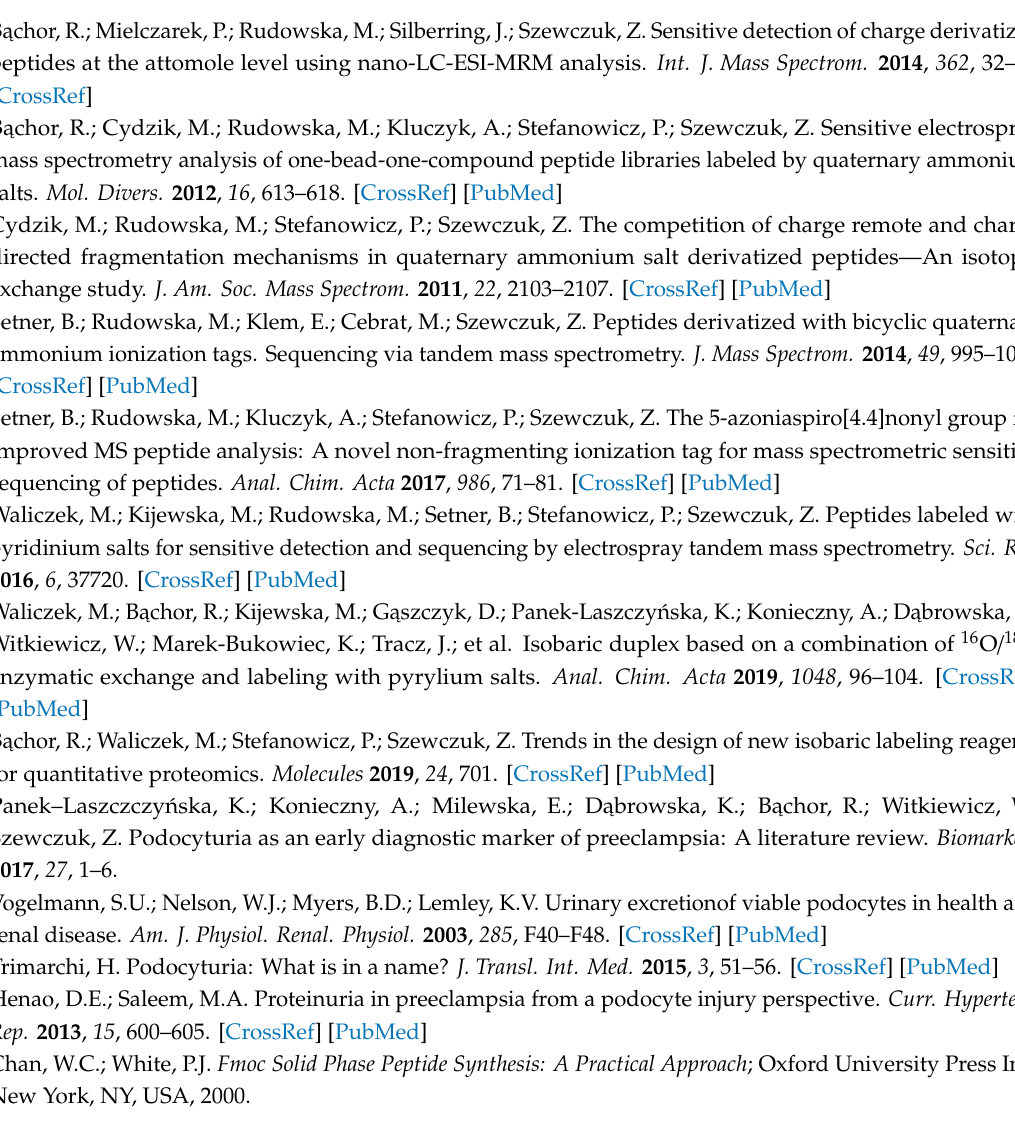
Sample Availability: Samples of the compounds including peptide and modified resin are available from the